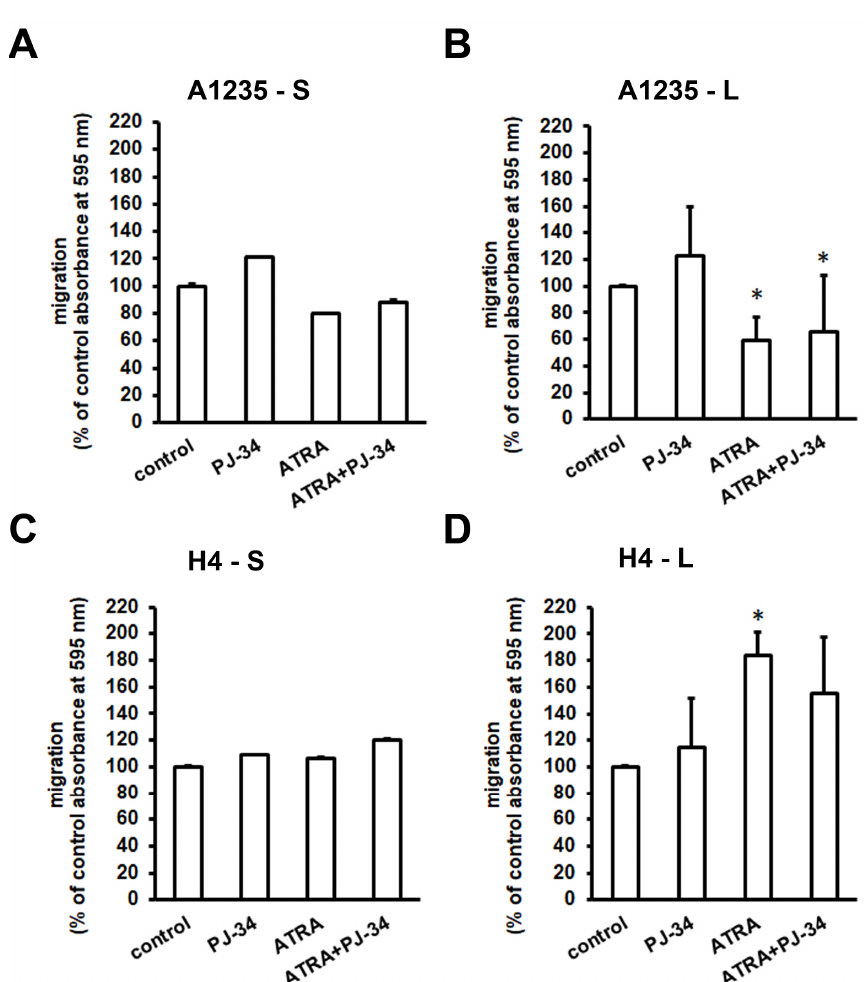
Figure 6. Analysis of cell migration after ATRA and PJ-34 treatment: Cells were seeded in Transwell chambers and allowed to migrate toward the medium with serum in the presence or in the absence of ATRA or PJ-34. Membranes were stained with crystal violet, and the absorbance was measured spectrophotometrically. ( A ) A1235 cells’ migration after 1 day of treatment; ( B ) A1235 cells’ migration after prolonged treatment; ( C ) H4 cells’ migration after 1 day of treatment; and ( D ) H4 cells’ migration after prolonged treatment. S: 1-day treatment; L: prolonged treatment; PJ-34: cells treated with 20 µM PJ-34; ATRA: cells treated with 10 µM ATRA; ATRA + PJ-34: cells treated with 20 µM PJ-34 and 10 µM ATRA inhibitor. * The mean values were significantly different from the control ( p < 0.05). Experiments were done two times.